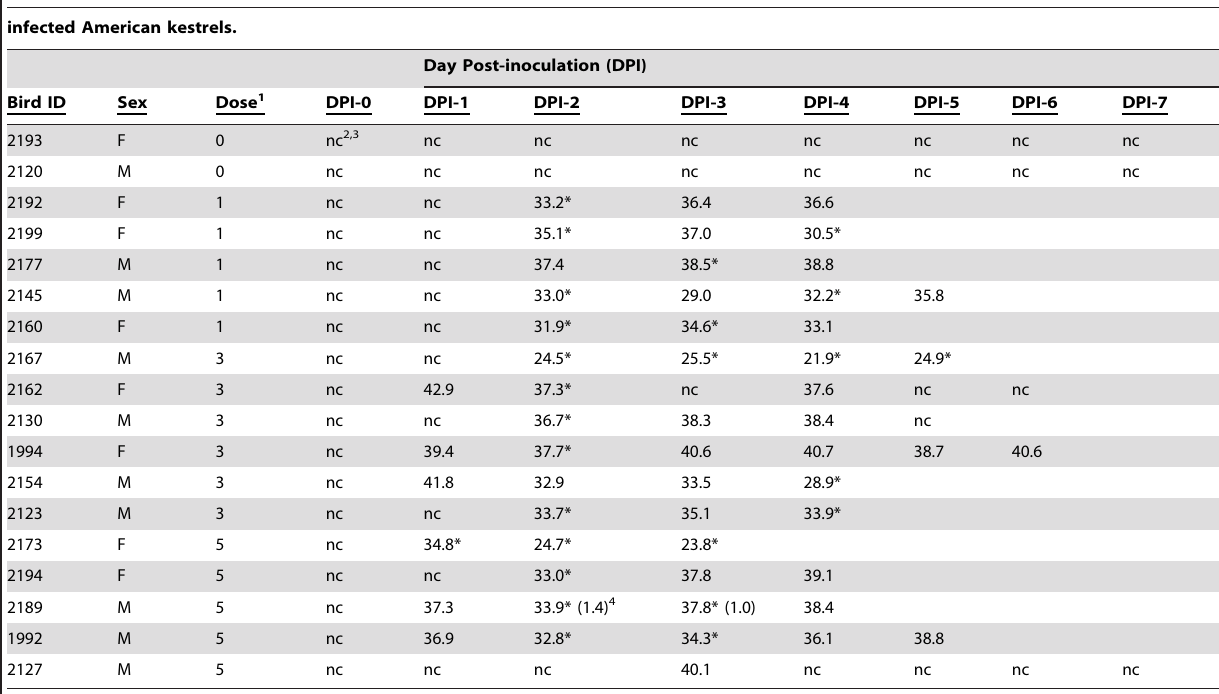
Table 2. Cloacal shedding of highly pathogenic avian influenza virus H5N1 by experimentally.